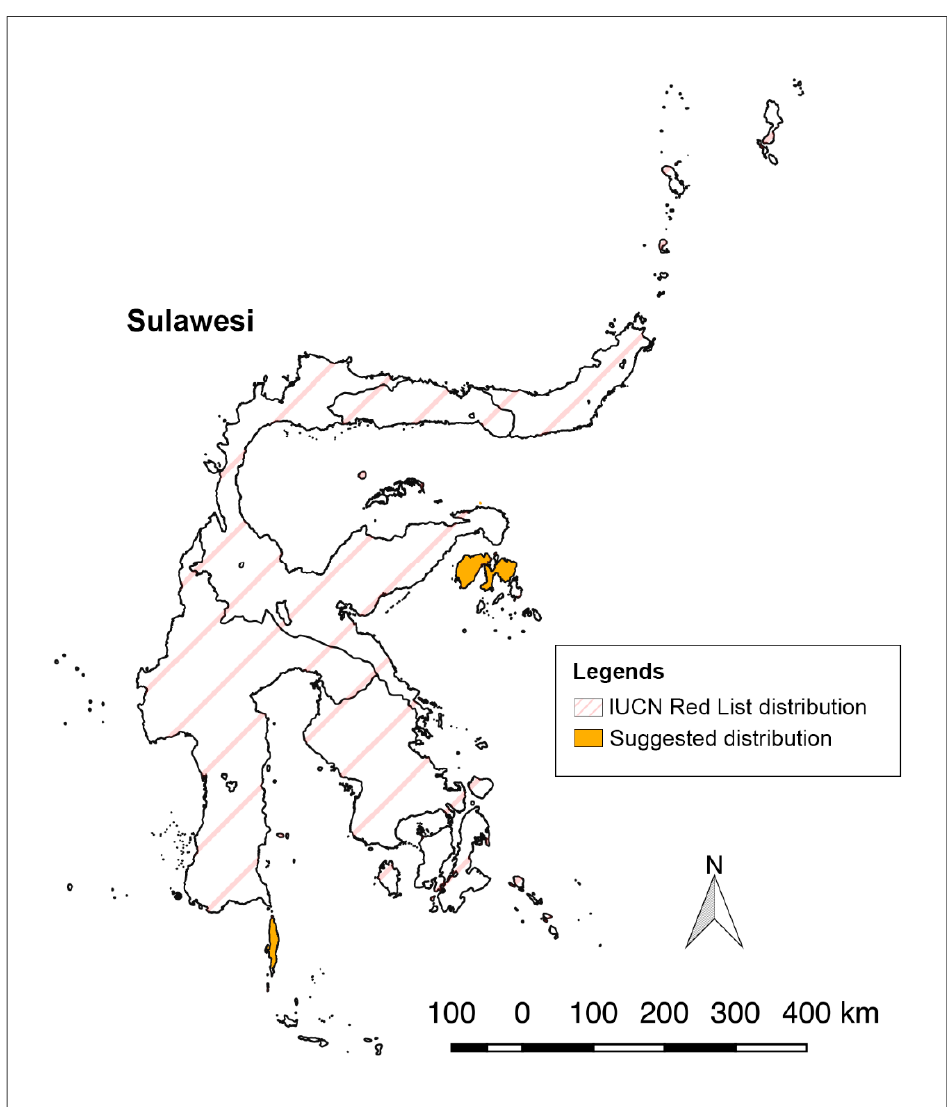
Figure 4. Map of suggested distribution (orange) for Pteropus griseus in Sulawesi for the IUCN Red List. The distribution takes into account precise localities where P. griseus has been found and represented by collection and observation records. We have included the current IUCN Red List distribution (striped pink) in order to highlight the large difference in geographic range estimates for Sulawesi using the old distribution. This maps excludes Pteropus griseus from other major archipelagoes in Indonesia.